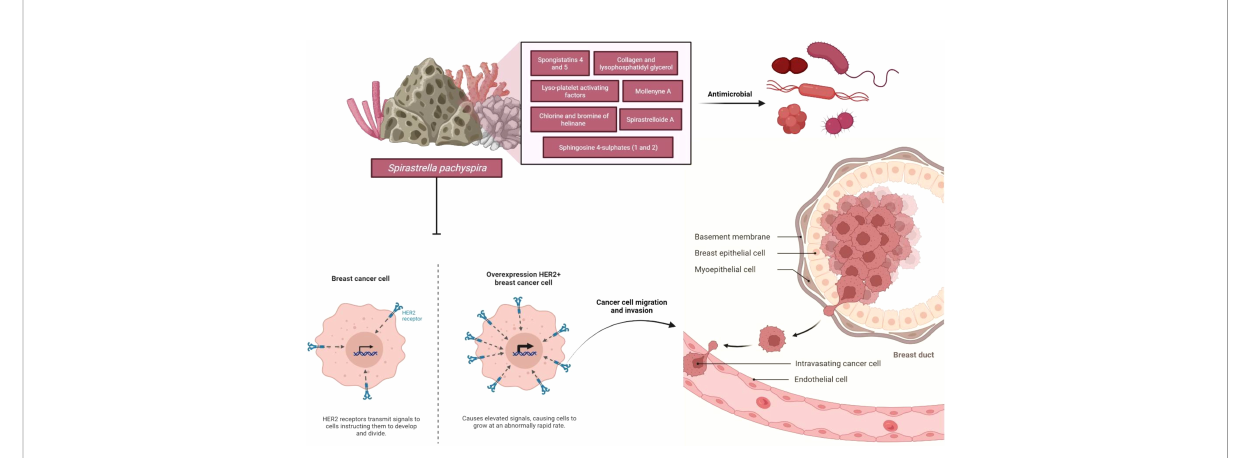
FIGURE 1 Schematic representation of the impact of anticancer effect of Spirastrella pachyspira against HER2-positive cancer cells along with its antimicrobial